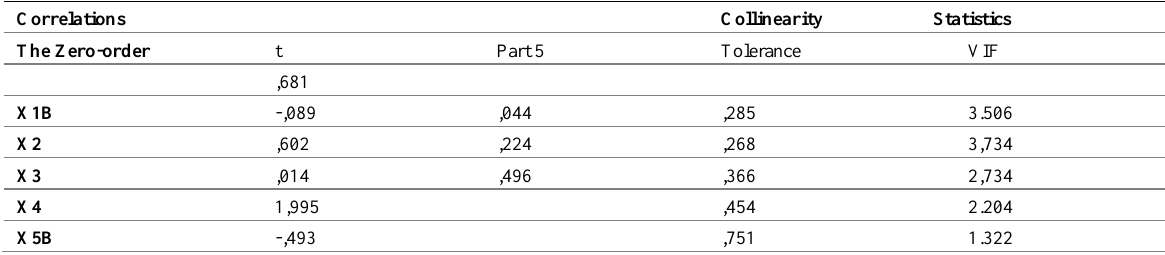
Table 2: Multicollinearity Test